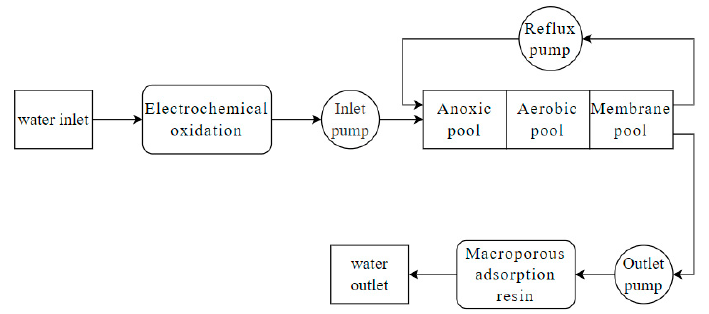
Figure 4. Hybrid treatment process of wastewater from an oil field [75].